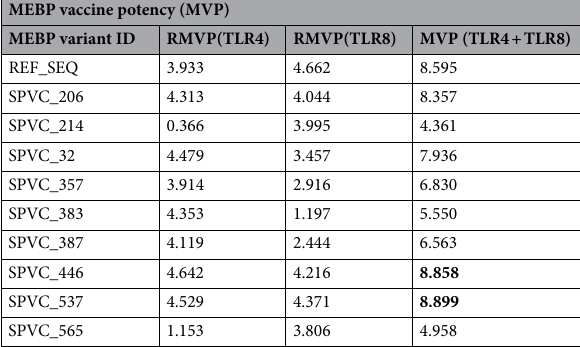
Table 6. MVP of each variant is calculated by adding receptor associated MVP (RMVP)s. RMVPs were calculated for the two receptors, TLR4 and TLR8 using the normalized values as described in the “Methods” section. Significant values are in